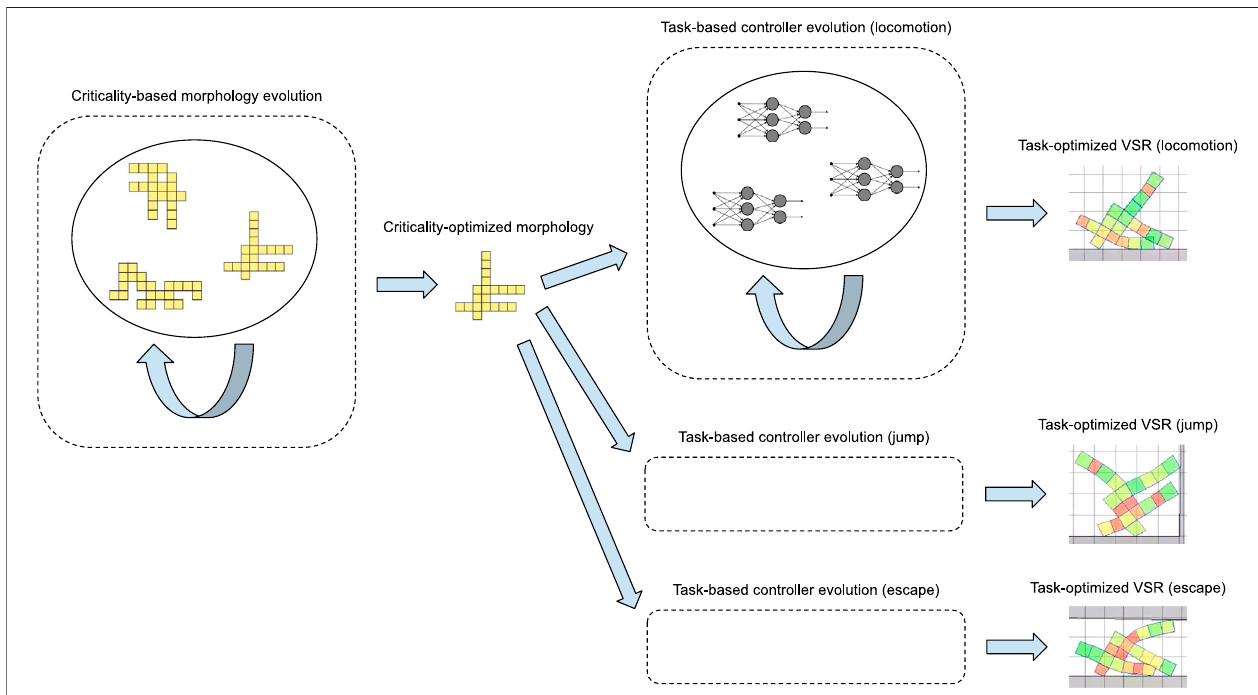
FIGURE 1 | Schematic view of our approach and its experimental evaluation. We fi rst evolve a morphology driving the optimization with a measure of its criticality: during this evolution (left), candidate morphologies are not evaluated on any speci fi c task. Then, we take a criticality-optimized morphology and test its adaptability, i.e., whether a VSR with a task-optimized controller working with this morphology obtains reasonable performance over a set of different tasks. For this evaluation, we evolve a controller (e.g., a neural network) for the criticality-optimized morphology: during each one of these evolutions (right), candidate controllers are evaluated, embedded in a robot with the criticality-optimized morphology, on a speci fi c